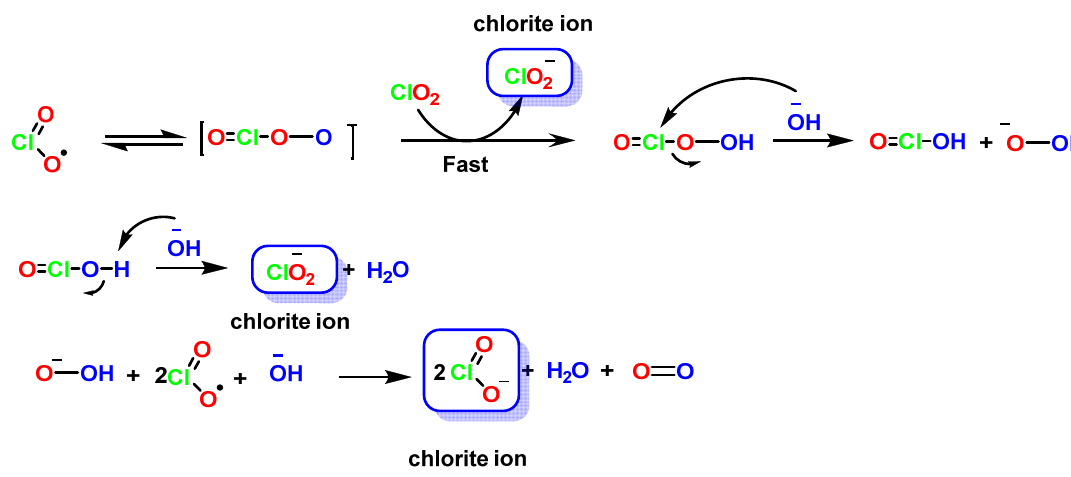
Figure 9. Mechanism of formation of equimolar amounts of ClO 2 − and ClO 3 − from ClO 2 in basic medium. basic medium.